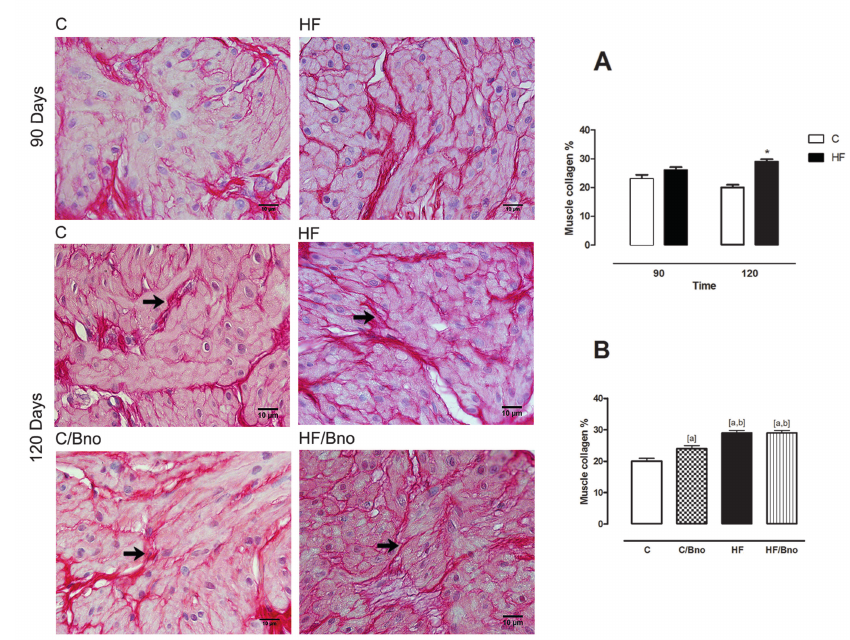
Figure 4 - Image showing the collagen in the detrusor muscle